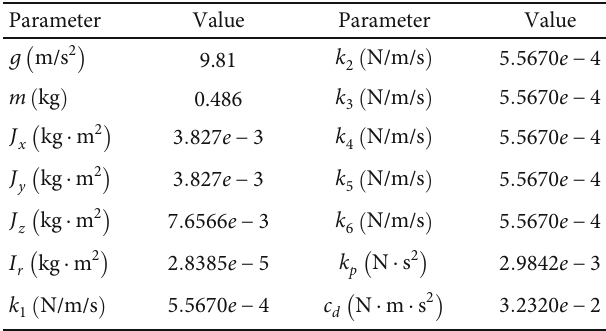
Table 1: Quadrotor